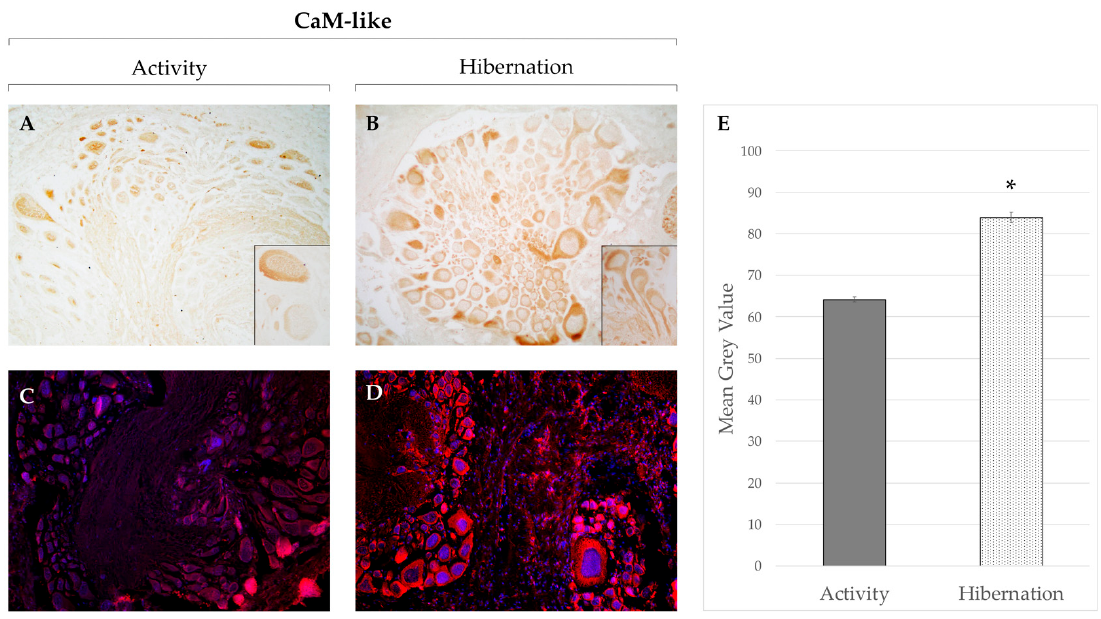
Figure 2. Immunohistochemistry with light ( A , B ) and fluorescence ( C , D ) microscopy for the Ca2+-binding protein calmodulin-like (CaM-like) in the suboesophageal ganglia of Cornu aspersum during activity and hibernation. In active snails, pale CaM-like immunoreactivity was detected across the ganglion ( A , C ) with only few sparse cells showing strong staining in the cytoplasm ( A , insert). Hibernating suboesophageal ganglia showed a stronger and more diffuse positivity to CaM-like in all panels evaluated ( B , D ). The signal could be detected in both the somata and axons of most neurons ( B , insert). Quantitative analysis on immunofluorescence labeling demonstrated that the change between activity and hibernation is highly significant (asterisk: Student’s t test, p value < 0.01) ( E ). Experiments were carried out as described in [133]. Magnification: 10× (A–D).